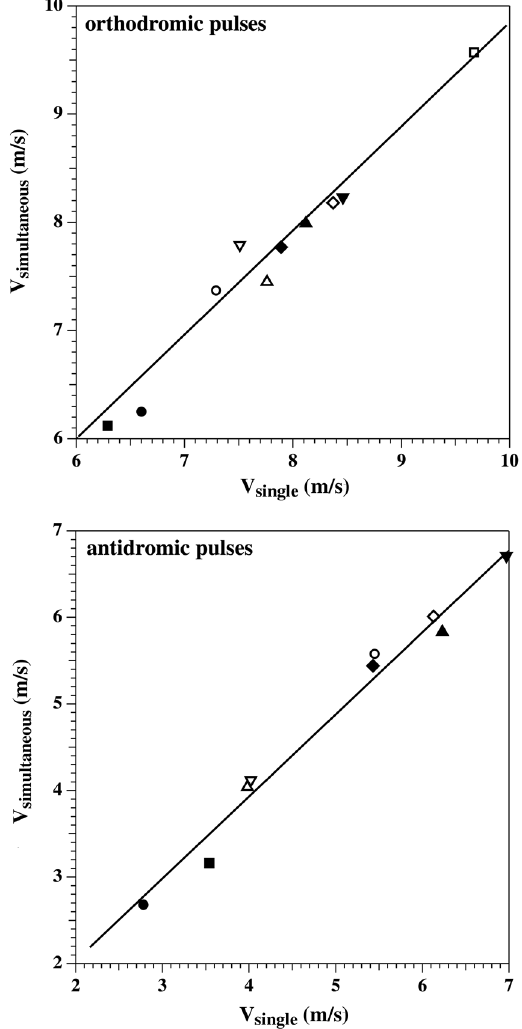
FIG. 7. Pulse velocities obtained in the collision experiment in the earthworm (simultaneous stimulation) versus the velocities of the single stimulation (using the first extremum of each pulse recording). Top panel: Orthodromic pulses. Bottom panel: Antidromic pulses. The same symbols in both panels indicate identical nerve preparation. The open square corresponds to the traces in Fig. 6 (sample #7). The experimental temperature was 22 (cid:2) 1